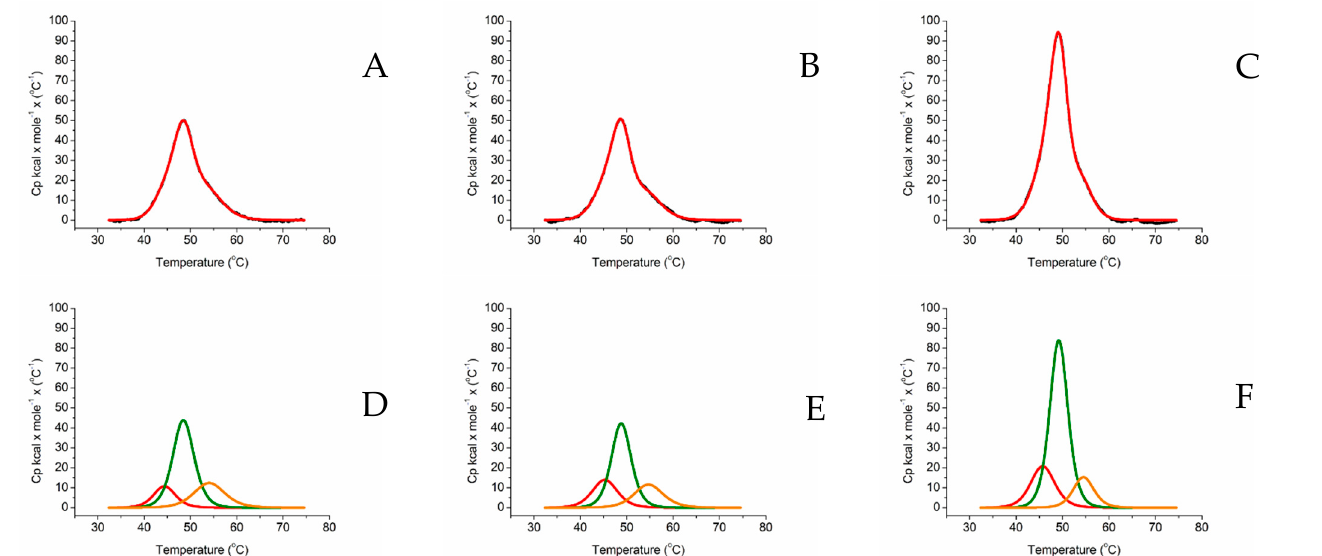
Figure 4. Thermal unfolding measured by DSC of 3A4 ‐ BMR chimeras. Thermograms of ( A ) 3A4 ‐ BMR, ( B ) 3A4 ‐ BMR ‐ 3GLY, ( C ) 3A4 ‐ BMR ‐ 5GLY. All experiments were carried out at a scan/rate of 90 °C/h. The black lines are the experimental curve of the chimeras, the reds line are the result of the fitting applying a non ‐ two ‐ state denaturation model. Deconvolution of 3A4 ‐ BMR ( D ), 3A4 ‐ BMR ‐ 3GLY ( E ), 3A4 ‐ BMR ‐ 5GLY ( F ). The red lines represent the deconvolution of the denaturation curve of CYP3A4, the green lines represent the deconvolution of the FAD subdomain from BMR, and the orange lines represent the deconvolution of the FMN subdomain from BMR.